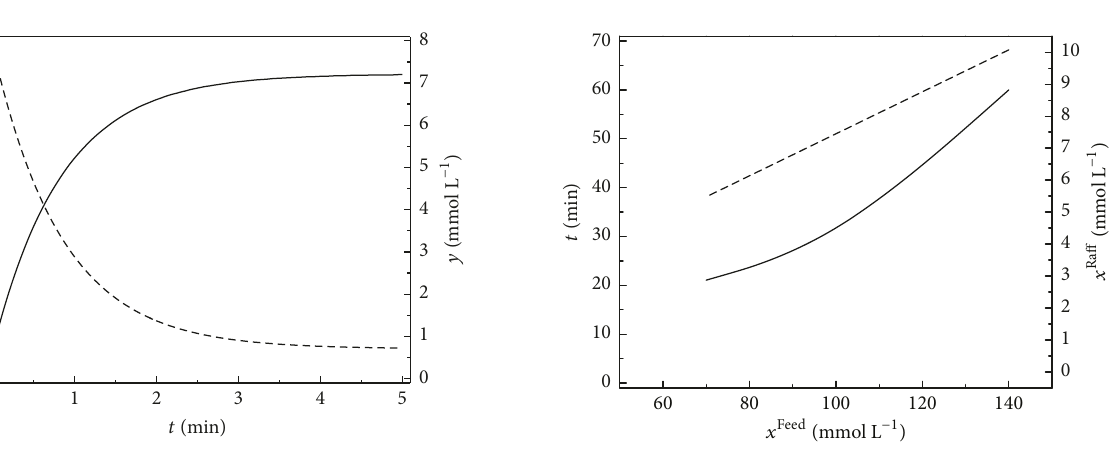
Figure 16: Adsorption time (solid line) as a function of the initial concentration of the impurity in the oil phase ( 𝑥 Feed ), for a required residualconcentrationattheoutletoftheadsorptioncolumn( 𝑦 break ) of 0.70 mmol L −1 . Resulting 𝑥 Raff as a function of 𝑥 Feed (dashed line). 𝑊 Ads = 1334